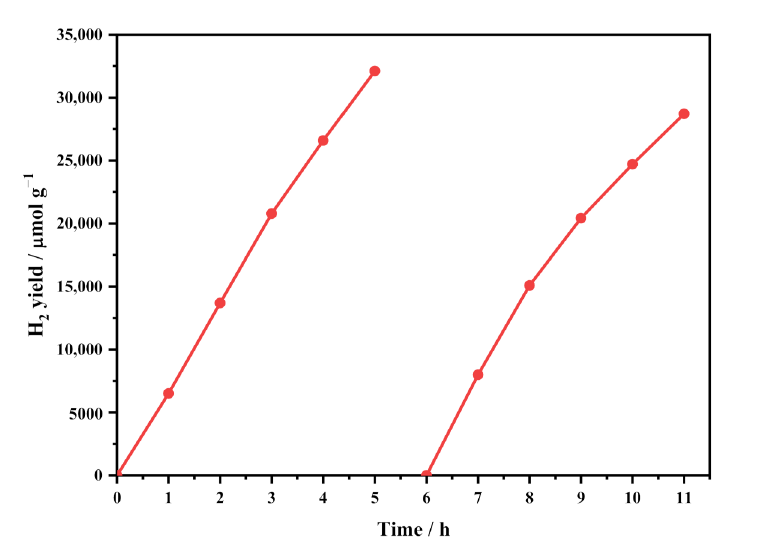
Figure 6. H 2 evolution recycle experiments of g-C 3 N 4 /MOC-Q2 (0.7 wt%) under visible light